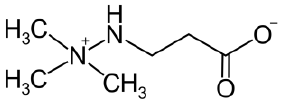
Figure 1. The chemical structure of meldonium (trade name